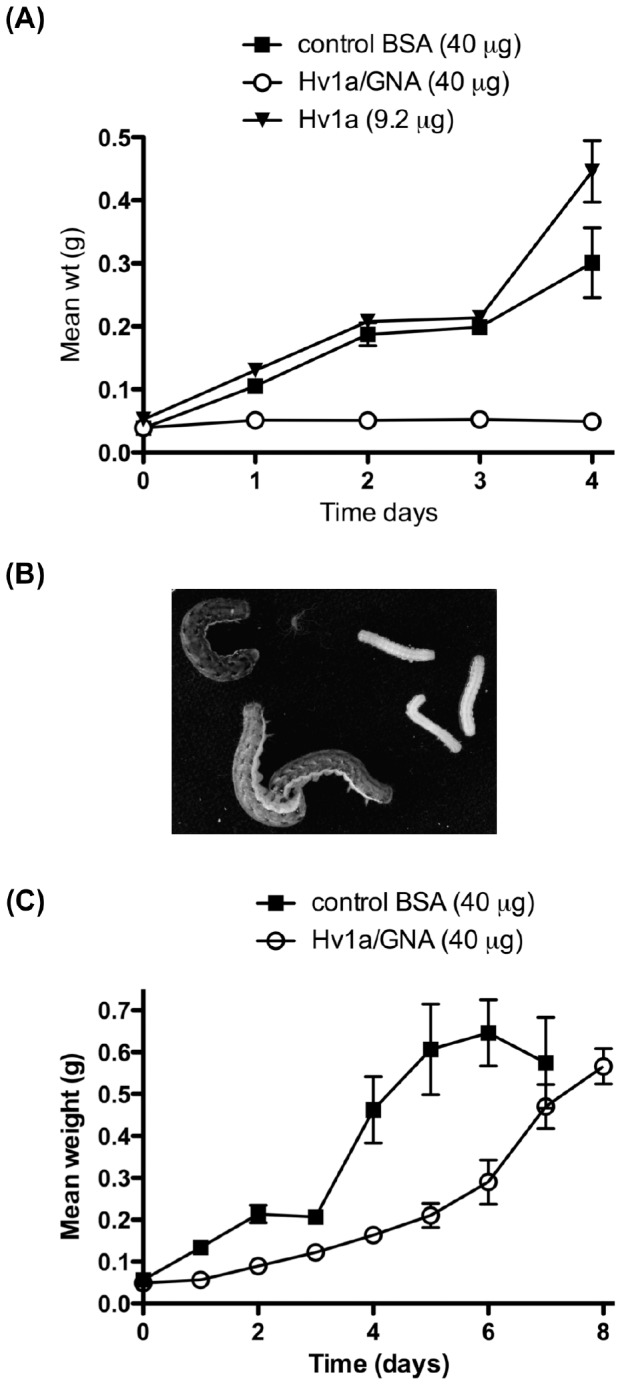
Droplet feeding assays.(A) Mean weight of fifth stadium M. brassicae larvae fed daily sucrose droplets containing either 9.2 µg Hv1a, 40 µg Hv1a/GNA, or 40 µg bovine serum albumin (BSA, control). Significant differences between Hv1a/GNA and control or Hv1a treatments were observed at days 1–4 (ANOVA Tukey post hoc; day 1, P = 0.0003; days 2–4, P<0.0001). (B) Image depicts larvae assayed in (A); control larvae on the left (BSA- and Hv1a-fed larvae) and Hv1a/GNA-fed larvae on the right. (C) Mean weight of fifth stadium M. brassicae larvae fed a single sucrose droplet containing either 40 µg Hv1a/GNA or control 40 µg BSA. Differences in mean weights between control and fusion protein treatments were significant from day 1 to day 6 of the assay (t-test; P<0.05).